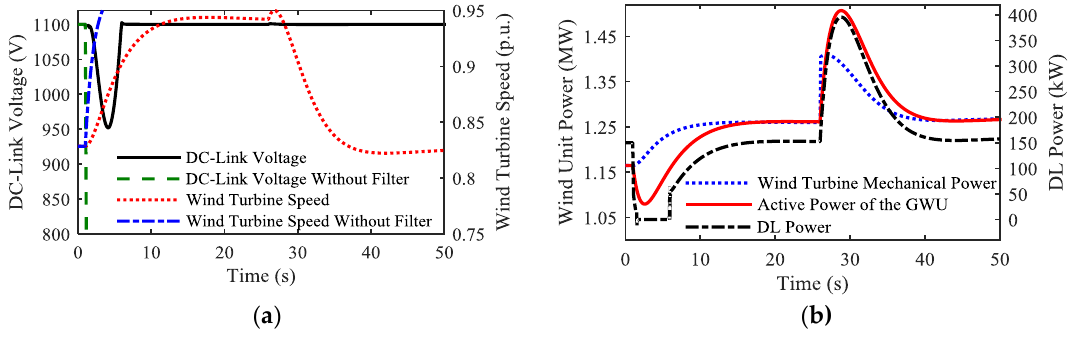
Figure 12. System dynamics for the scenario corresponding to the wind-only mode: ( a ) DC-link voltage and wind turbine speed; ( b ) Power in different components of the system.